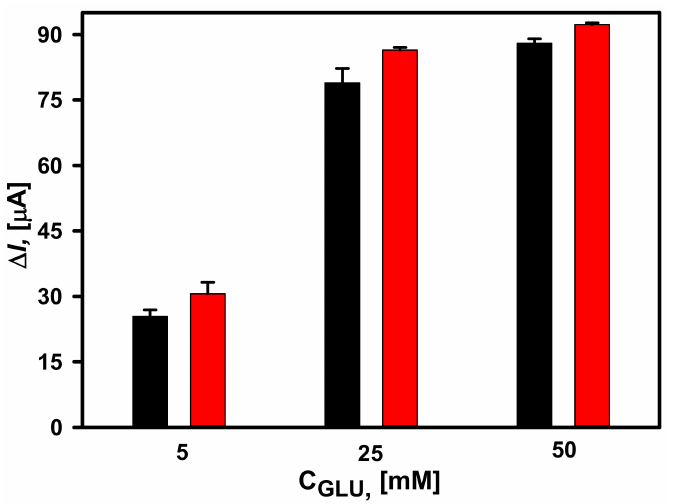
Figure 2. Dependence of the current response of glucose biosensors based on electrochemically deposited DGNs from a 10 mM HAuCl 4 solution with 0.1 M KNO 3 at a constant − 0.2 V potential for 200 s (red column) and 400 s (black column). The amperometric response at +0.3 V was registered in 0.05 M SA buffer with 0.1 M KCl (pH 6.0) and 2.0 mM PMS.